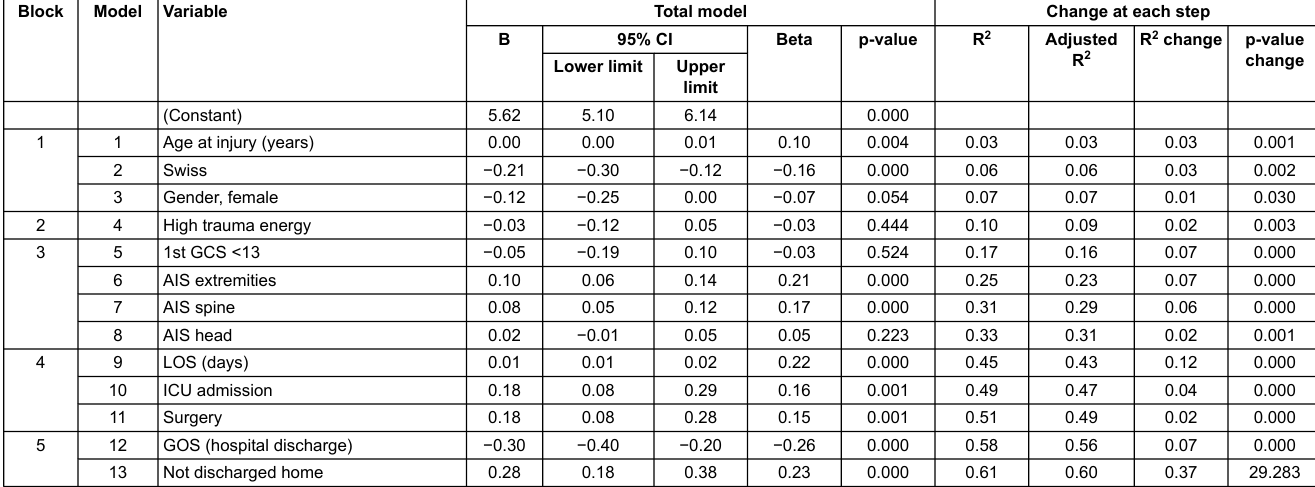
Table 3: Multivariate analysis of demographic, injury and early hospital characteristics of survivors of trauma explaining logarithmic total insurance costs. Block Model